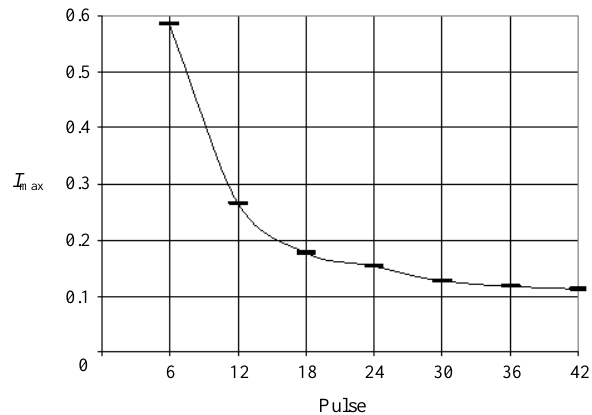
Fig. 13. Dependence of the rectifier input current maximum deviation from sine wave on the rectifier pulse. The studies show that the input current amplitude value of active or passive ideal corrective filters is 57 % to 12 % of the inverter input current amplitude, depending on rectifier pulses.